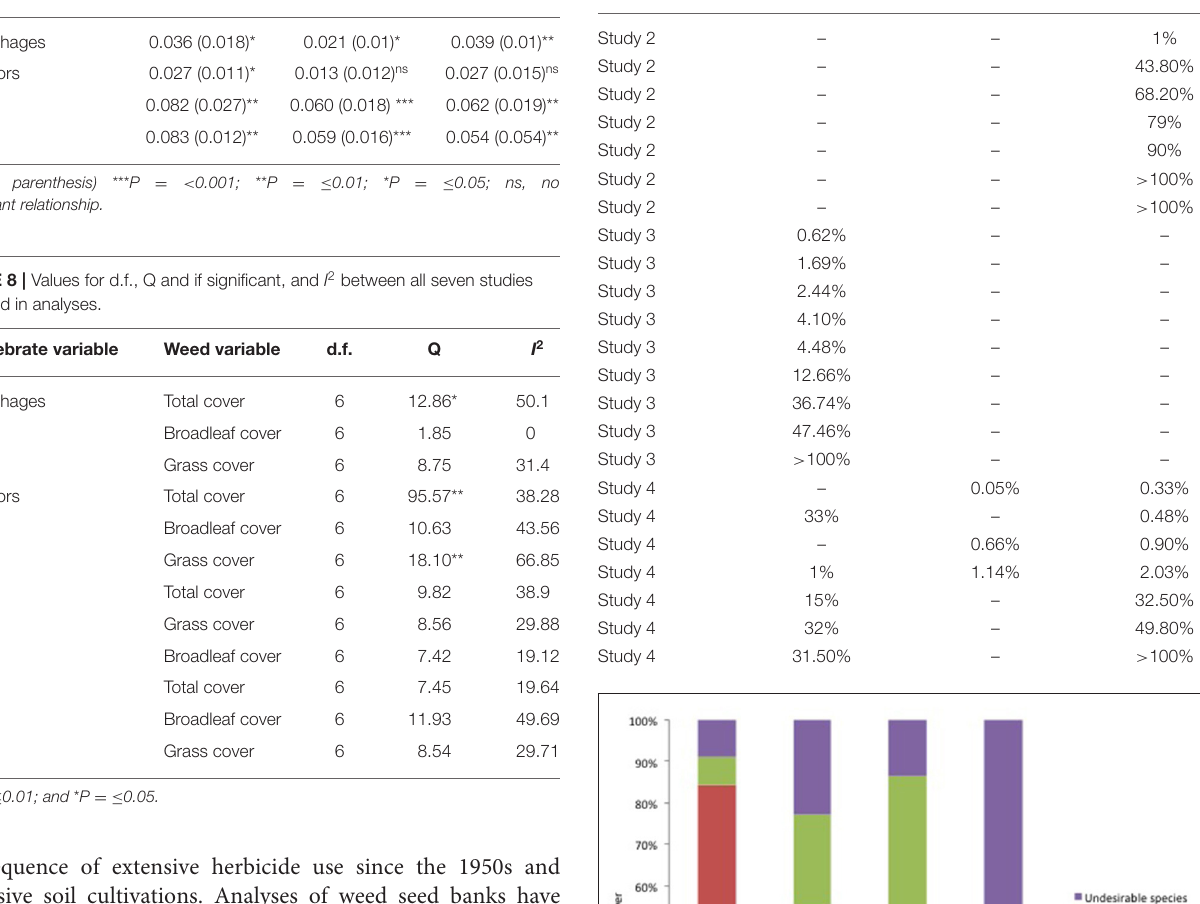
TABLE 7 | Summary effect sizes (regression coefficients) derived from a random effects meta-analysis. Invertebrate variable